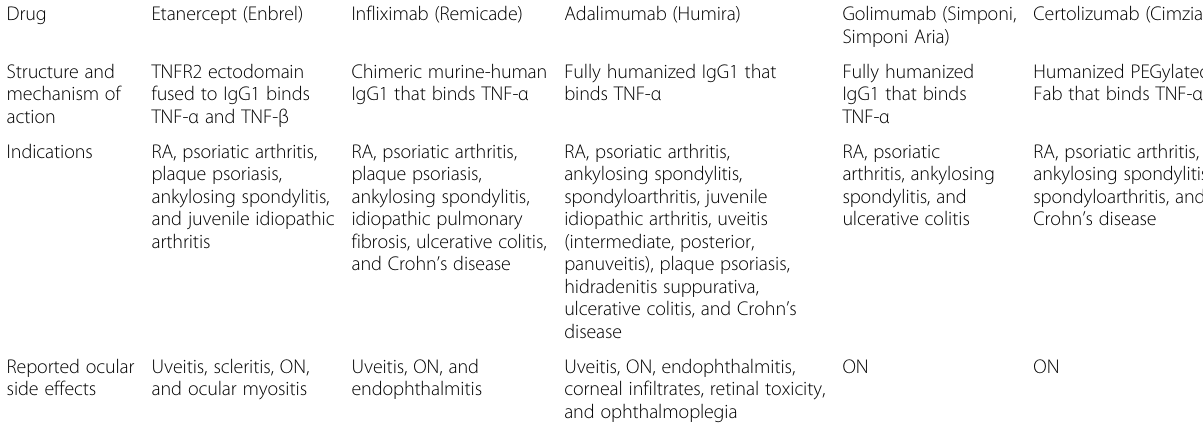
Table 1 Monoclonal antibodies Drug